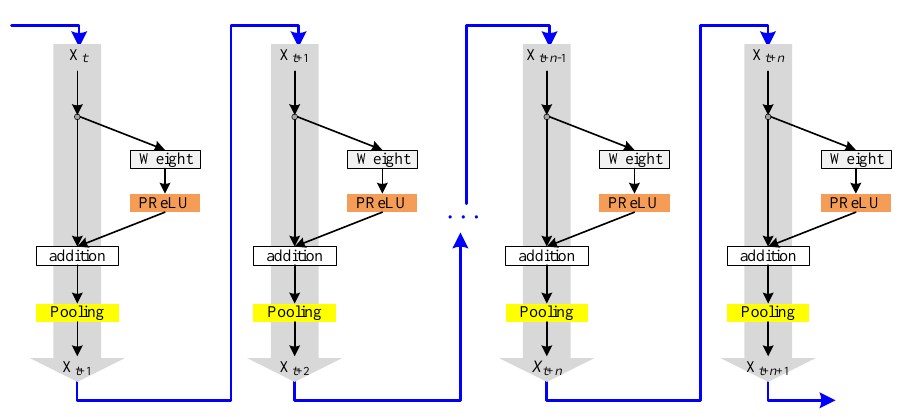
Figure 6. The S-ResNet layer.